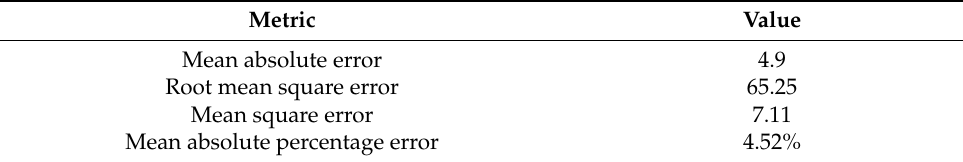
Table 13. Common metrics result for model SARIMA (1, 0, 1) × (0, 1, 1) 12.